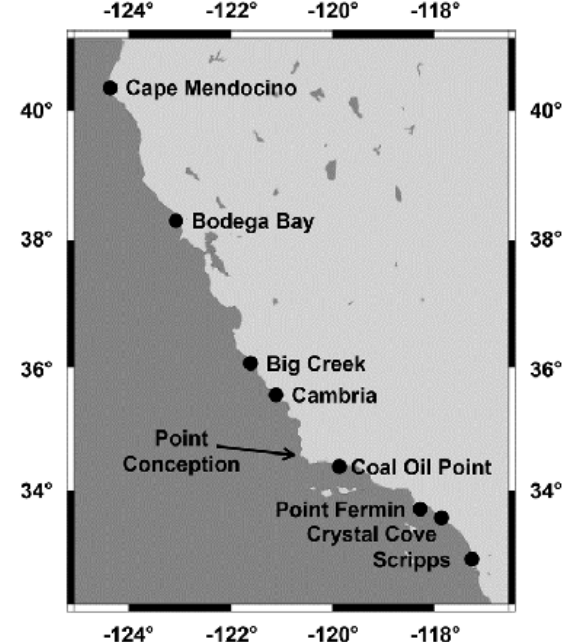
Figure 1. Eight study sites spanned the California, USA, rocky shoreline. Cape Mendocino, Bodega Bay, Big Creek, and Cambria are north of Point Conception. Coal Oil Point, Point Fermin, Crystal Cove, and Scripps are south of Point